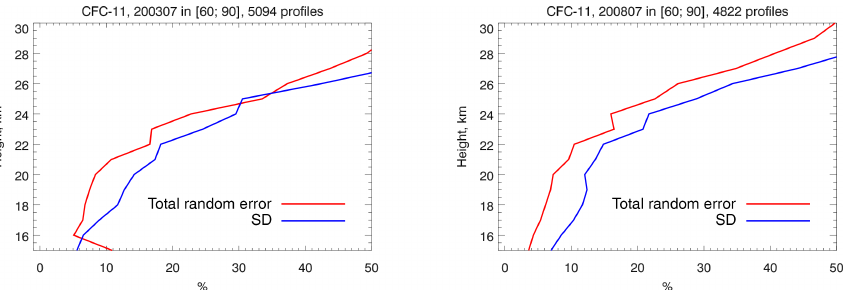
Figure 32. Analysis of MIPAS CFC-11 measurement error in quiescent atmospheric conditions (polar summer). Left panel: FR period; right panel: RR period.